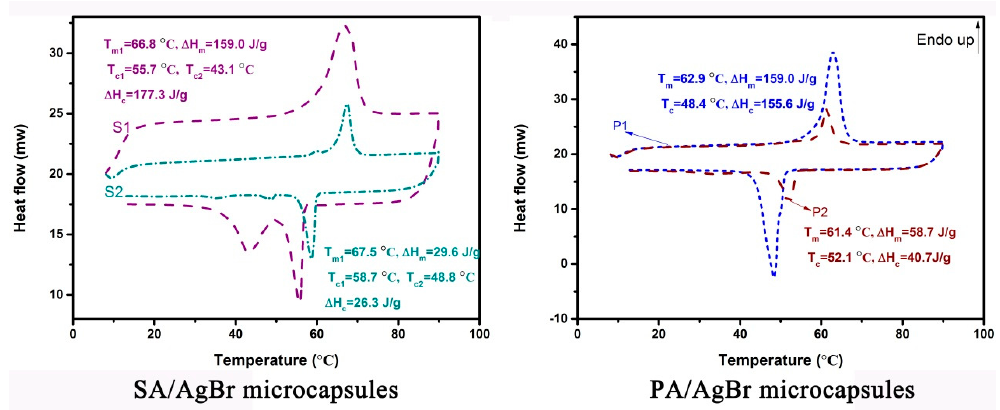
Figure6. X-ray diffraction of the beeswax/AgBr microcapsules.